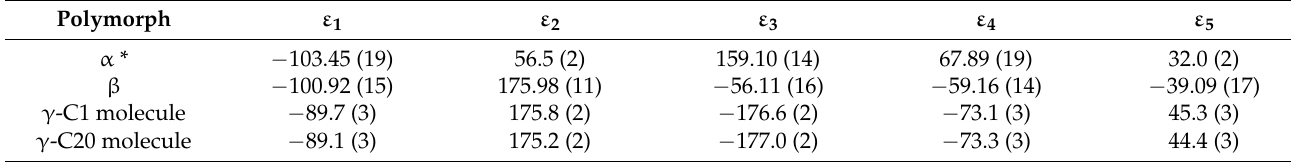
Table 1. Key torsion angles ( ◦ ) in the polymorphs of C 19 H 22 ClN 5 O · 2H 2